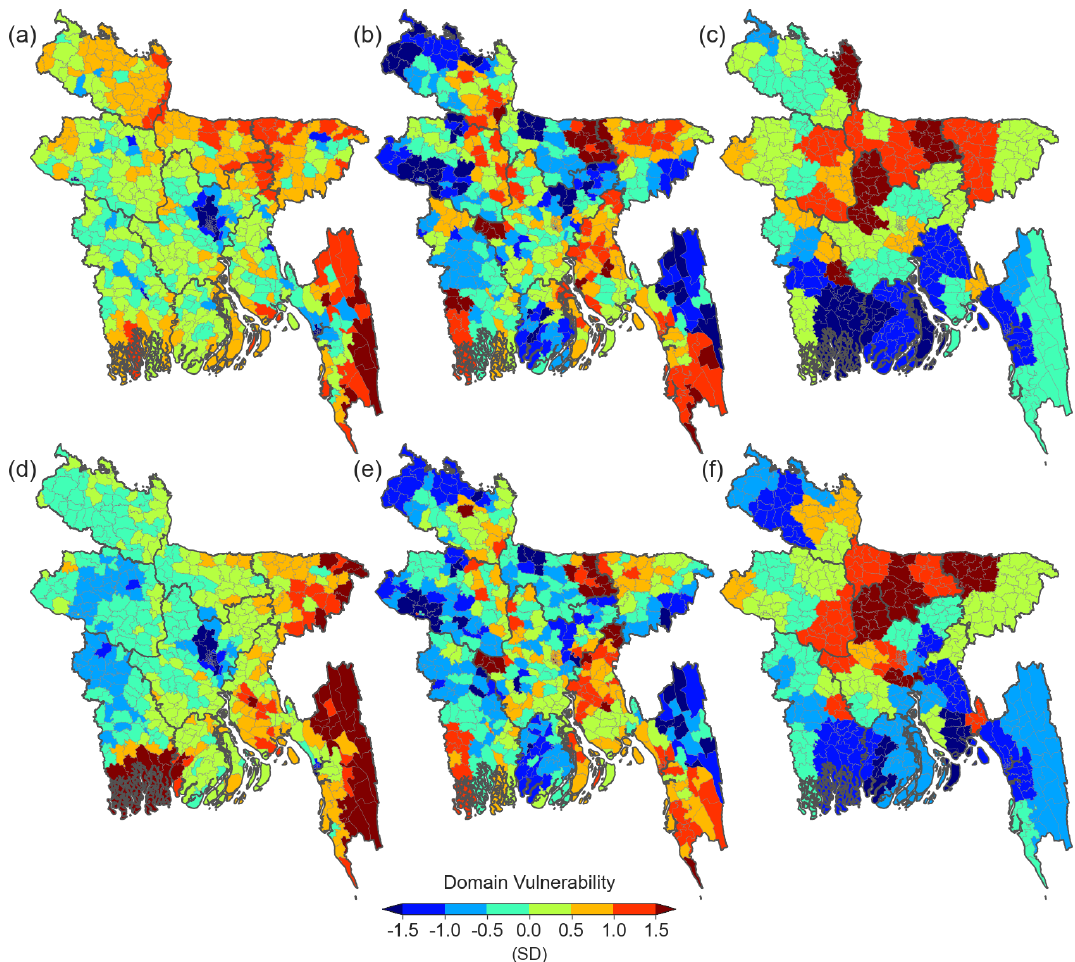
Figure 4. The domain vulnerability index of (a, d) socioeconomic, (b, e) health, and (c, f) coping capacity domains using the equal-weight (a– c) and PCA (d–f) approaches. The unit is the standard deviation (SD) from the